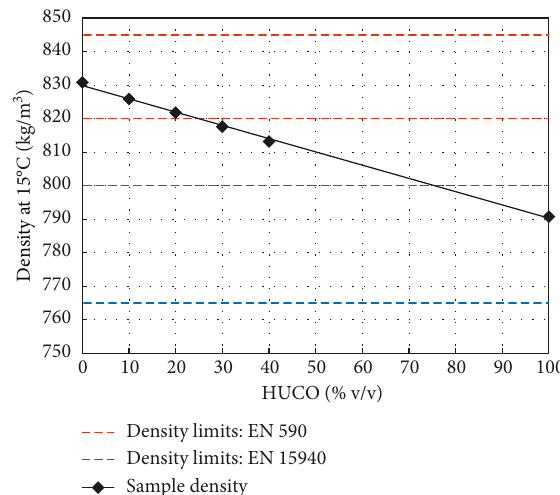
Figure 3: Density at 15 ° C of ULSD, HUCO, and their blends, measured by EN ISO 12185 standard test method.